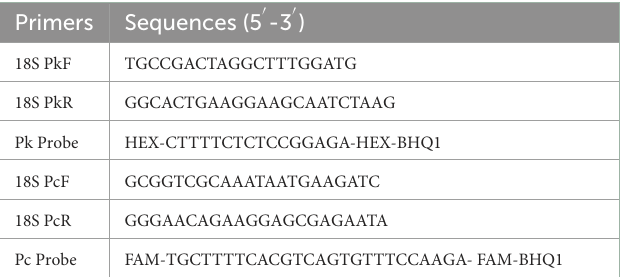
TABLE 1 List of qPCR primers and respective probes for amplification of Pk and Pc 18S rRNA target